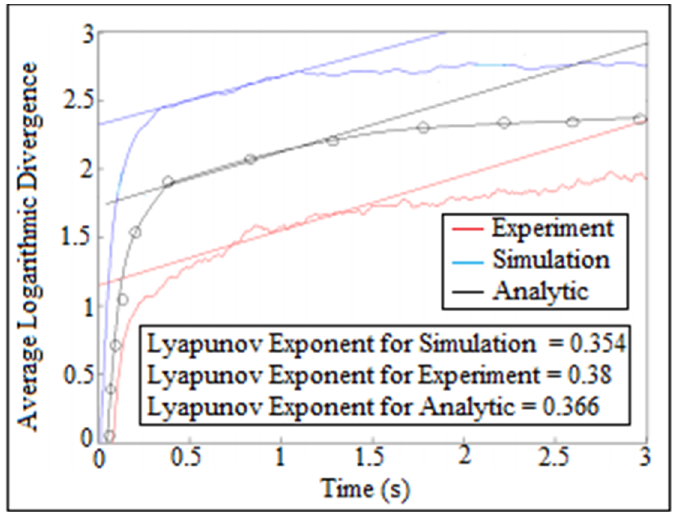
Figure 43. Average logarithmic divergence against the time for (I.D. = 18 mm) and (N = 200 rpm).